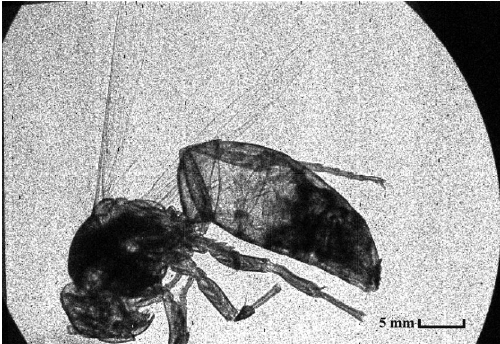
FIG. 27. LCS x-ray imaging of a hornet. The distance from the sample to the detector is 2.5 m for refraction contrast imaging.